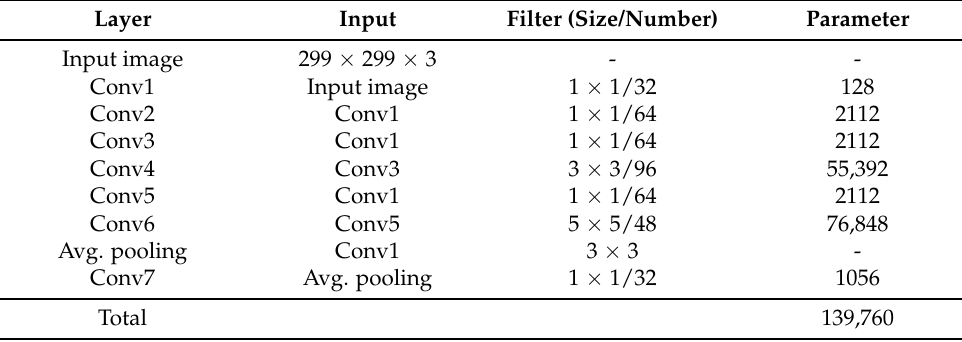
Table 3. Required parameters using standard convolution in the Inception block.